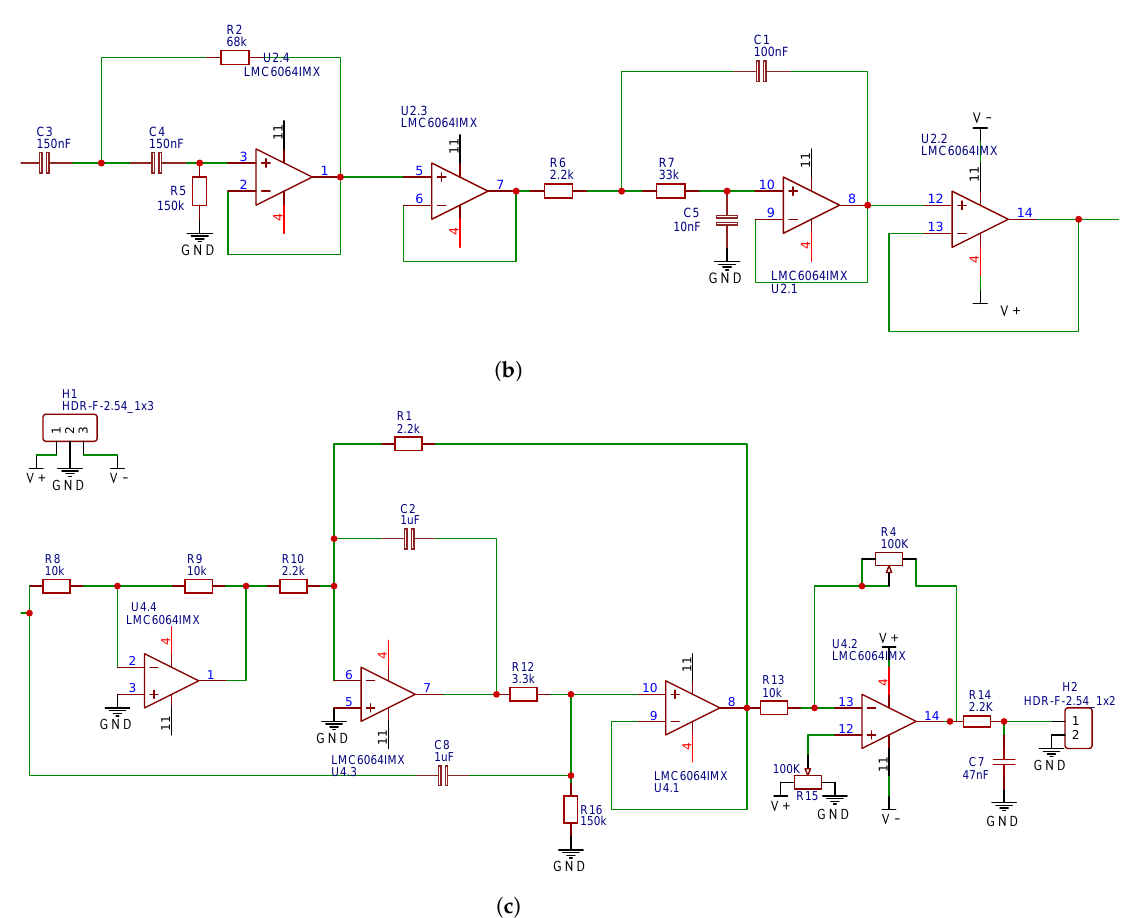
Figure 1. Electrical diagram of the complete EMG acquisition system. ( a ) The instrumentation amplifier is shown with the operational amplifier in integrating configuration, while in ( b ), the low-pass and high-pass filters are found. On the other hand, in ( c ), the notch filter and the offset compensator are exemplified.